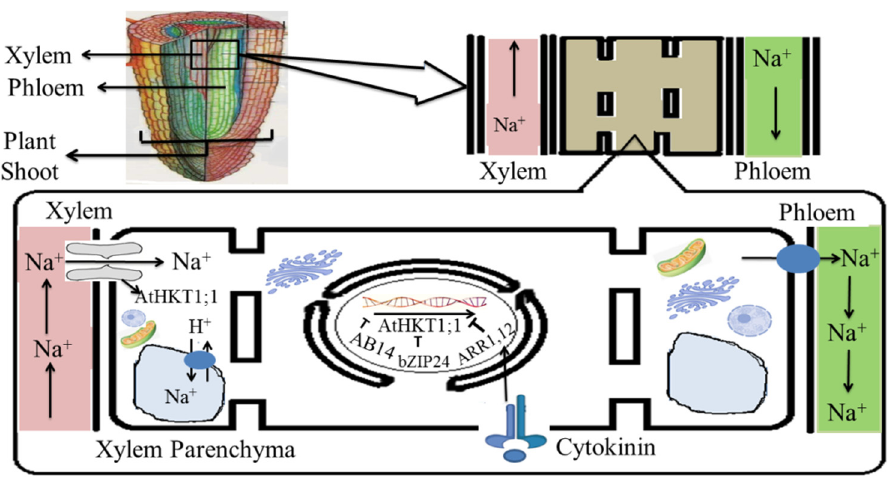
Figure 7. Model showing AtHKT1;1 and the negative regulators of AtHKT1;1 expression. contrasted to expression in Arabidopsis [161]. In Thellungiella , SOS2, NHX1, and HKT1 ,